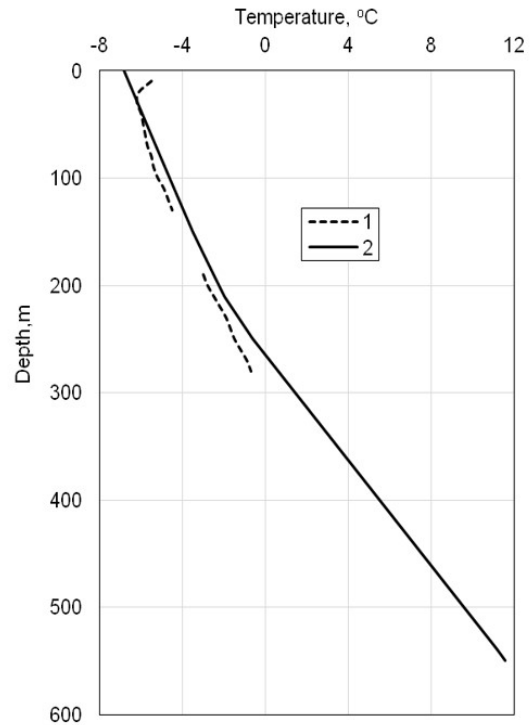
Figure 3. Temperature–depth profile from a site within the Bovanenkovo gas-condensate field: well log (1) [52] and initial value used in calculations (2).